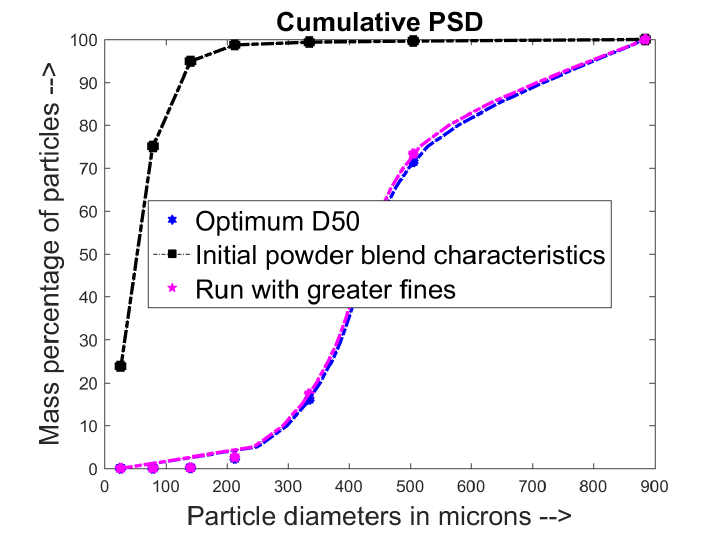
Figure 9. Mass PSDs for inital powder blend, final granular blends at optimum D50 run settings and at setting generating more